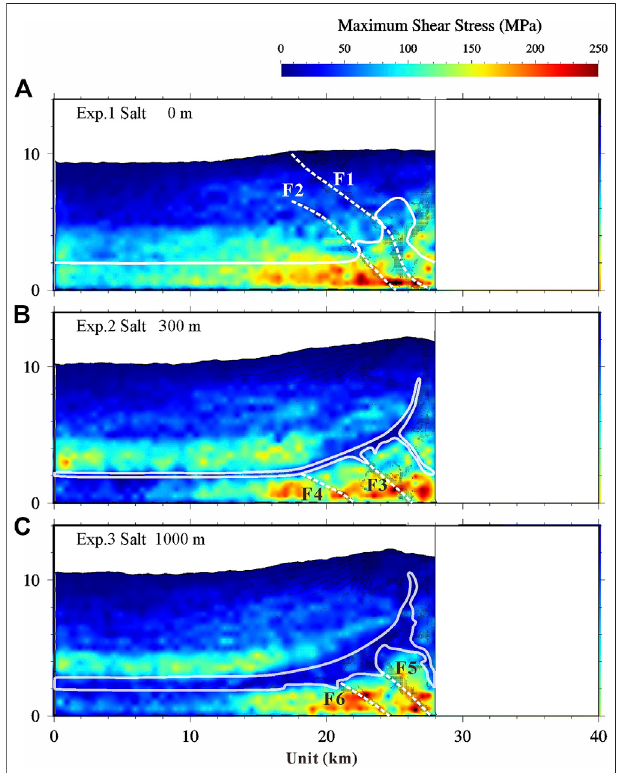
FIGURE 7 | Max shear stress illustrated after 12 km of shortening. (A) Reference experiment. (B) Experiment with thin salt (ca. 300 m). (C) Experiment with thick salt (ca. 1,000 m). The fi nal structure of each series is superimposed by plotting regions of high distortional strain (i.e., the absolute value is greater than 4.8 in Figure 6 ) in black. Dashed lines denote faults. The areas that are trapped by the white solid line denote the salt. The fi gures of max shear stress for each step are included in the Supplementary Material